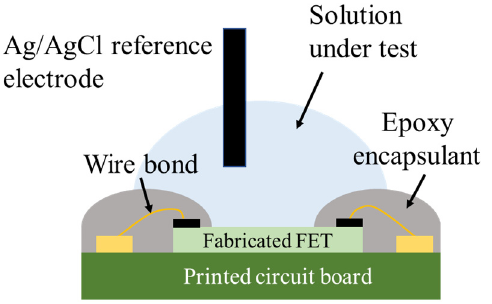
Figure 4. Schematic illustration of the cross-section of the device during measurement.